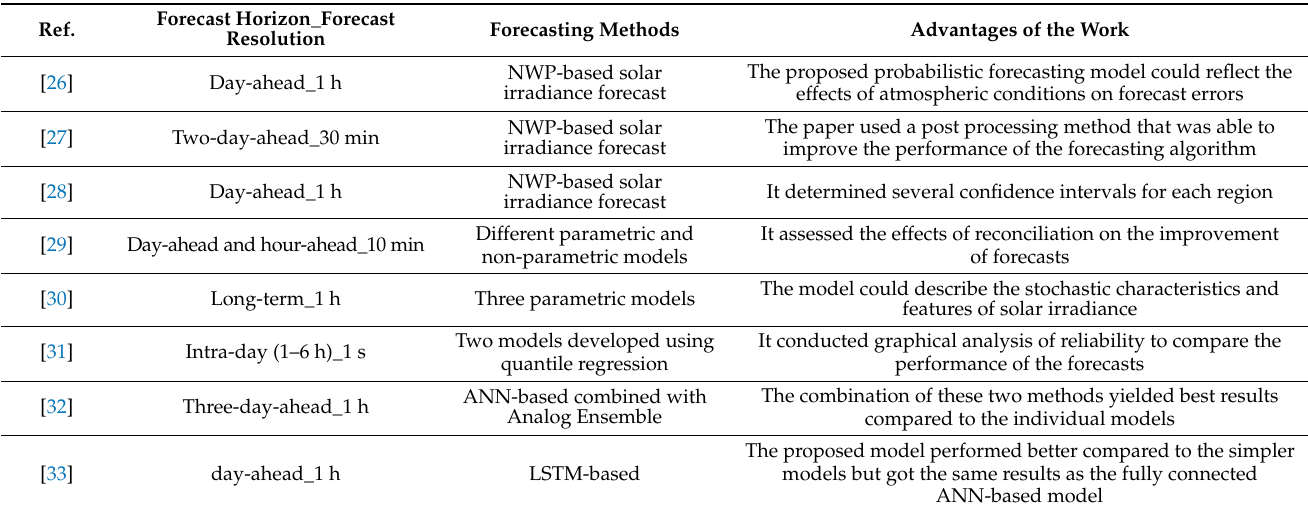
Table 2. An overview of selected papers developing probabilistic forecasting models for solar